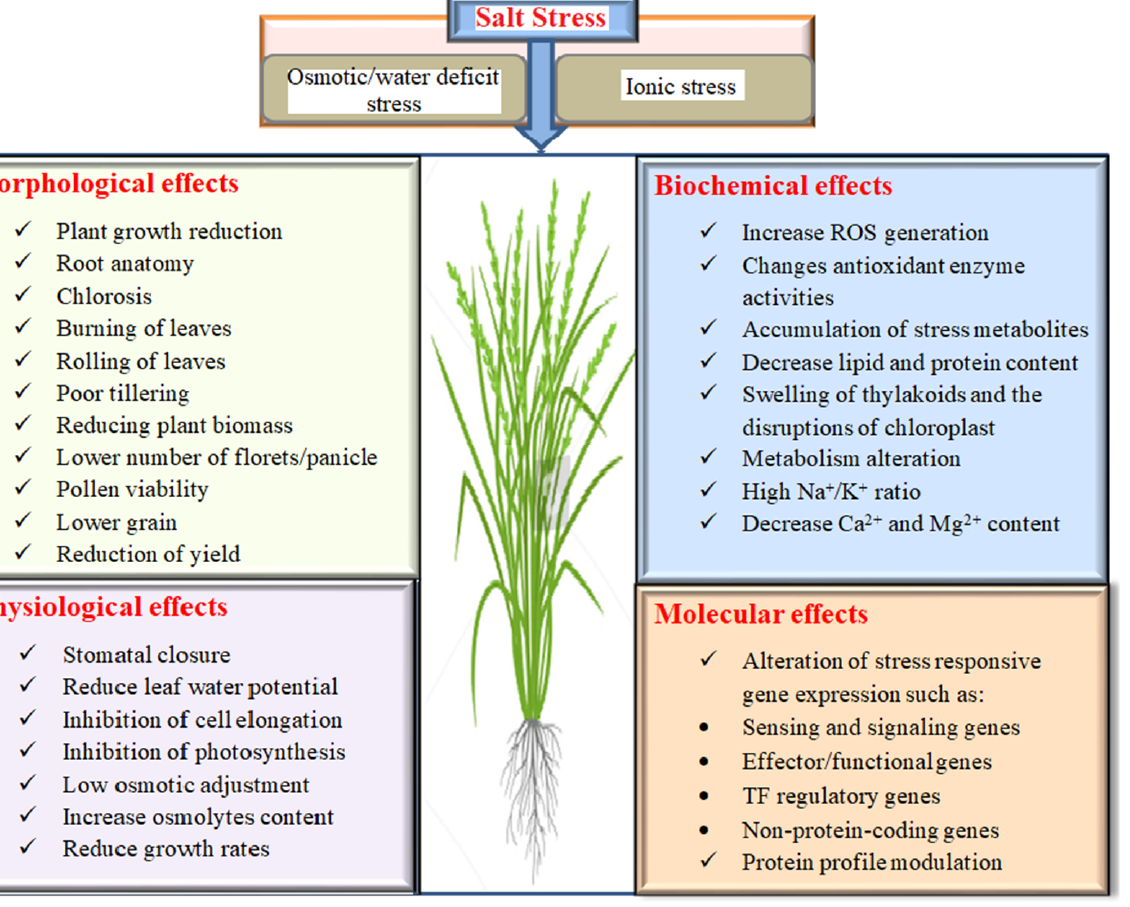
Figure 1. Various salinity effects on rice. At the morphological stage, it causes chlorosis, burning of leaves, rolling of leaves and poor tillering, disturbing plant development. At the physiological and biochemical levels, salinity interferes with critical plant functions such as photosynthesis, respiration and nutritional acquisition, as well as triggers the formation of ROS, which disrupts enzyme activity and impairs membrane integrity. Besides these effects, salinity alters several genes and protein expression profiles related to overall growth at the molecular level.